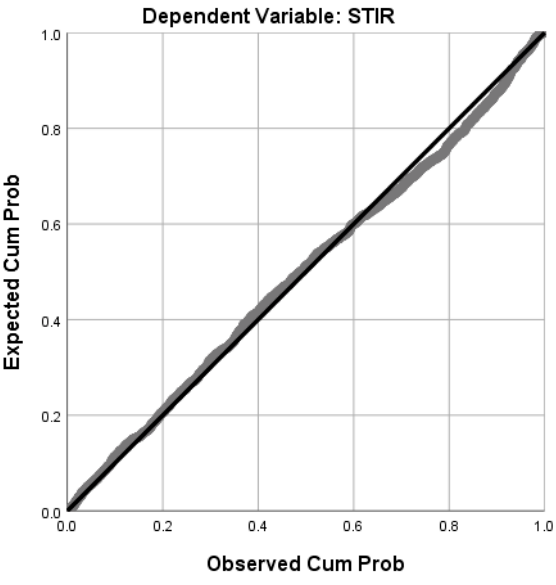
Figure 5. The Normal P-P Plot of LR model.